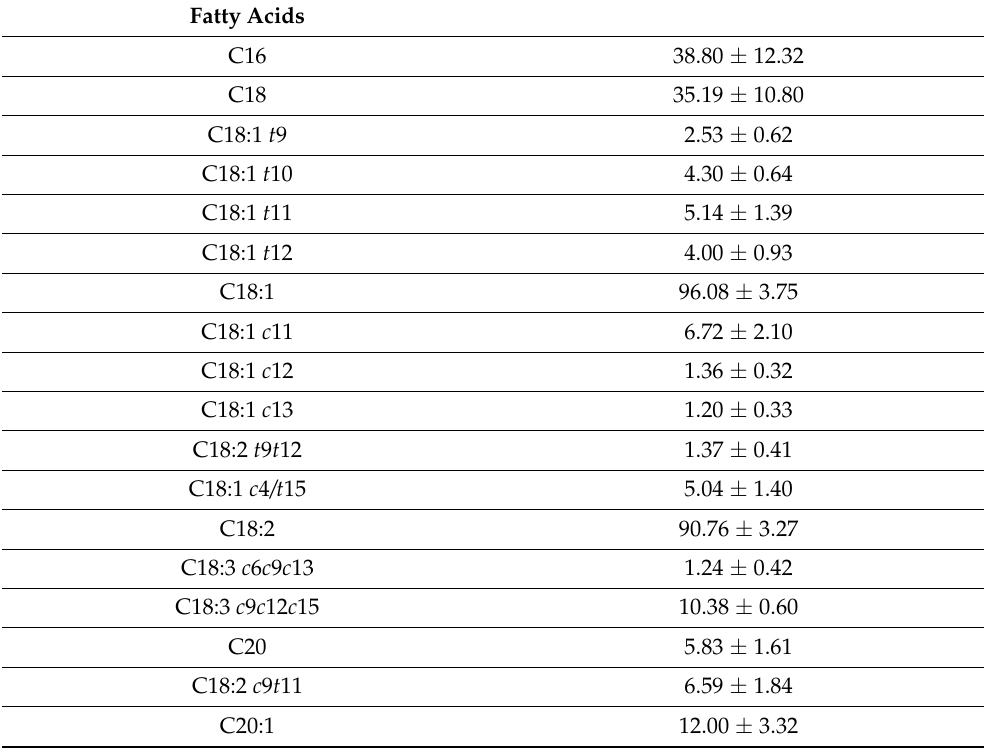
Table 1. Fattyacidsprofileofpomegranateoil. Allvaluesareexpressedinmg/mL(mean ± standarddeviation). Fatty